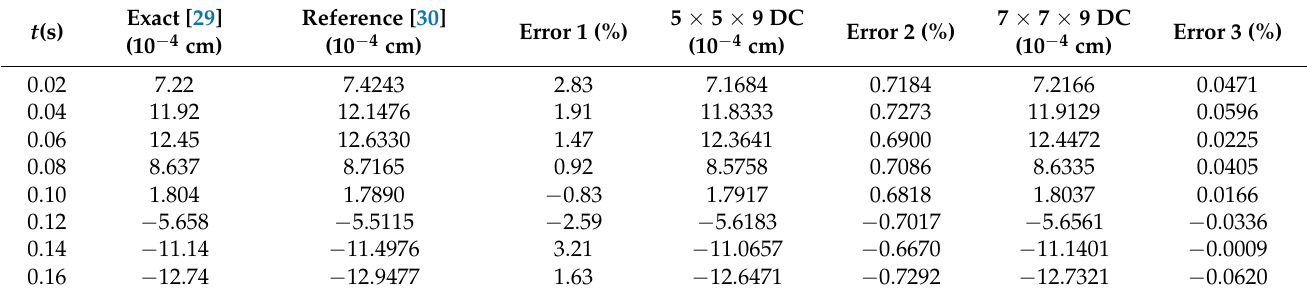
Figure 12. The displacement of the sheet at each time point. Table 4. The displacement at 8 time points of the center point of the four simply supported thin plate under the action of dynamic load q .